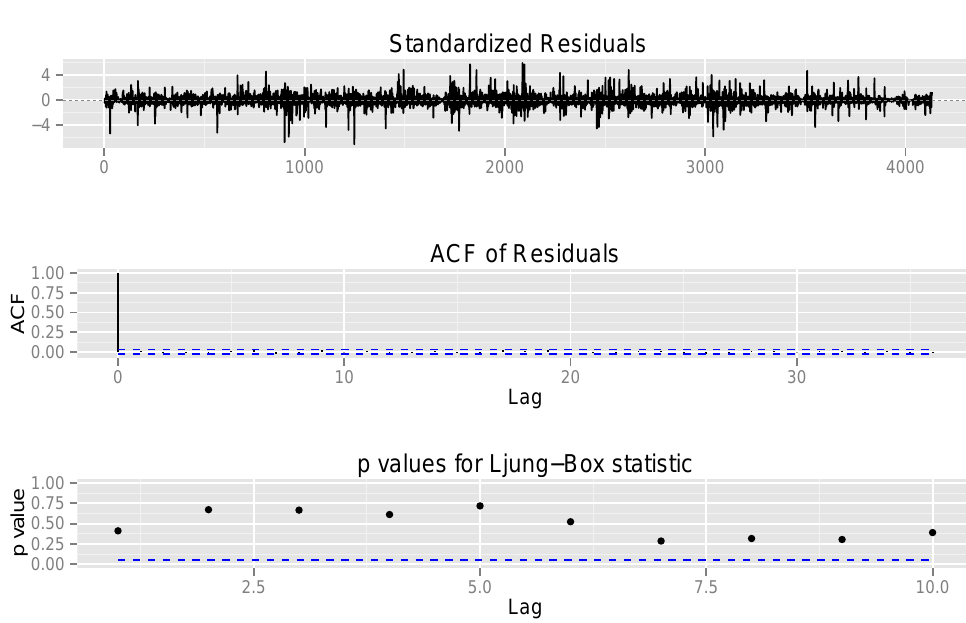
Figure 10. Jump Inter-Arrival Times, After Tick Size